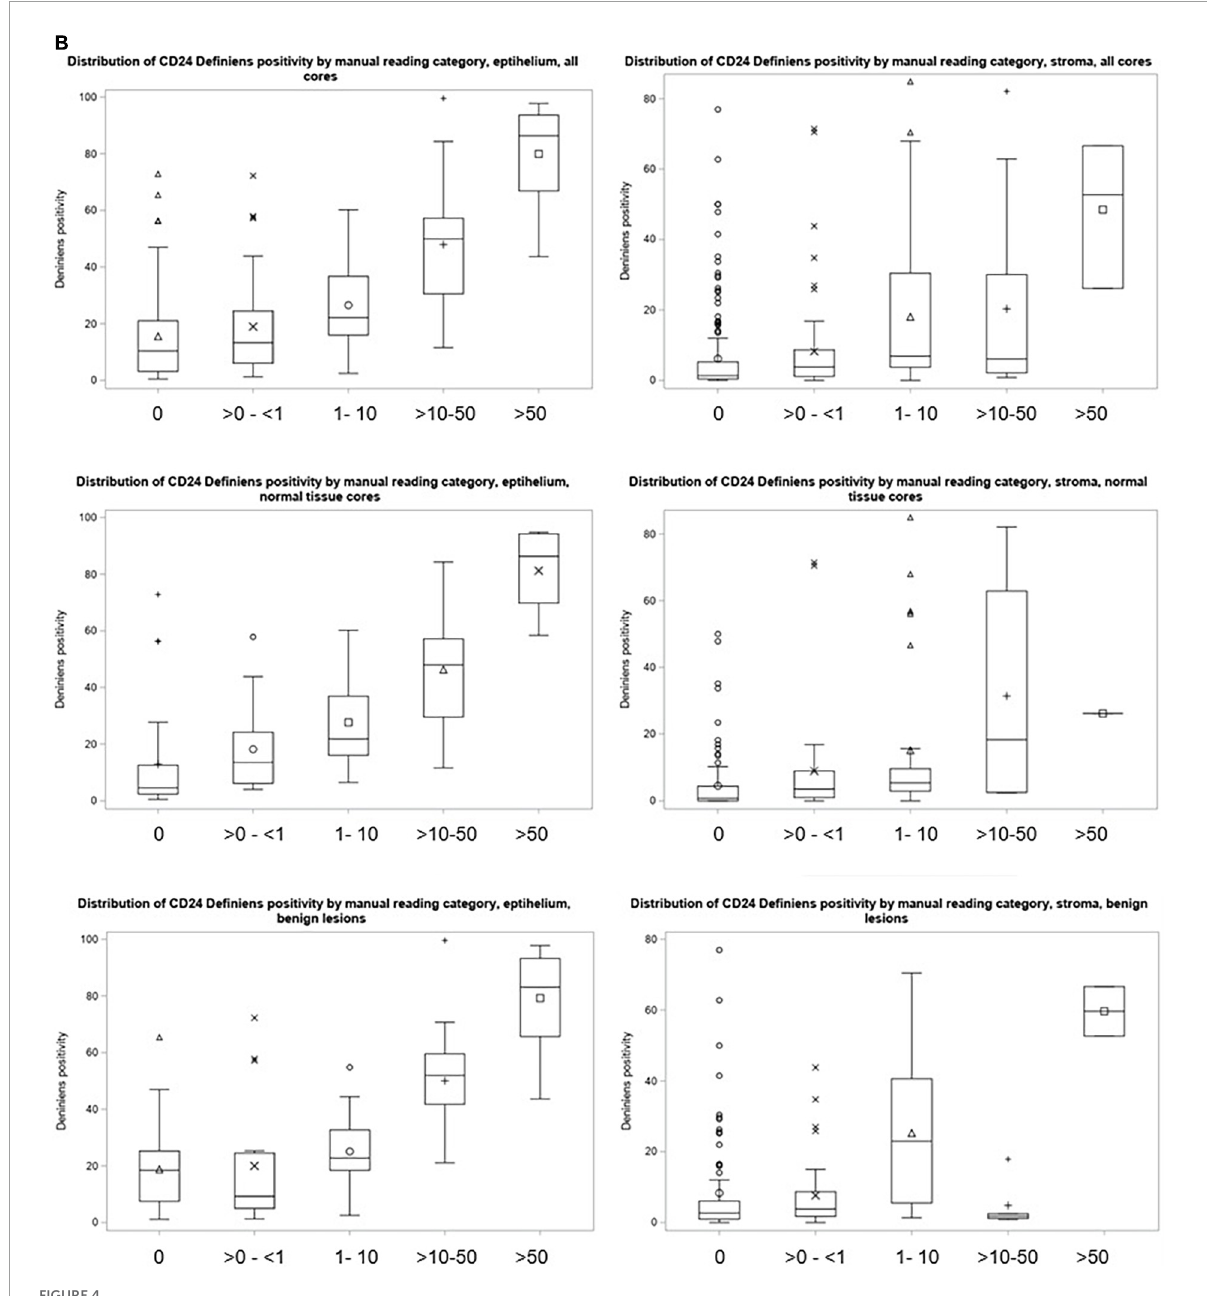
FIGURE4 (B) Distribution of CD24 Definiens positivity according to the manual reading